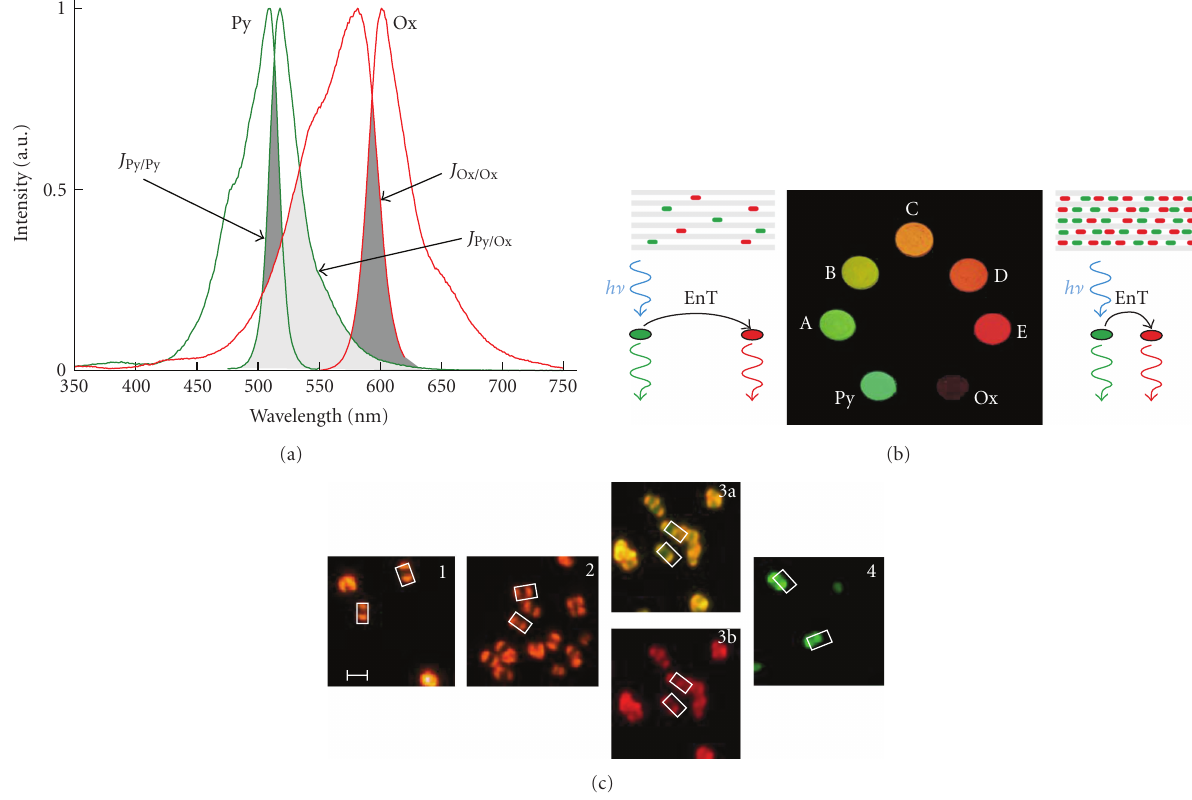
Figure 3: FRET case study on a mixed Py,Ox-zeolite L composite. (a) Excitation and fluorescence spectra of both dyes in zeolite L scaled to the same height at the maximum. The di ff erent overlap areas are indicated by grey shading. (b) Middle: photographic image of dye-loaded zeolite L layers upon monochromatic irradiation at 485nm and observation through a 500nm cut-o ff filter. The two samples indicated as P and Ox are references loaded with pure Py and Ox, respectively. Samples A to E contain a 1:1 mixture of Py and Ox with the following loading for each dye: A, p 1 / 2 = . 0014; B, p 1 / 2 = . 0035; C, p 1 / 2 = . 007; D, p 1 / 2 = . 014; E, p 1 / 2 = . 028. Left: Crystal and donor-acceptor pair describing the situation in sample A . Right: Crystal and donor-acceptor pair describing the situation in sample E [63]. (c) Fluorescence microscopy pictures, visualizing the di ff usion of Ox to Py in zeolite L, taken after 20 minutes (1), 60 minutes (2), 470 minutes (3a, 3b), and 162 hours (4), respectively. Py was specifically excited, with the exception of 3b, where Ox was specifically excited. Two crystals of each image are framed. The scale given in 1 corresponds to a length of 1.5 μ m